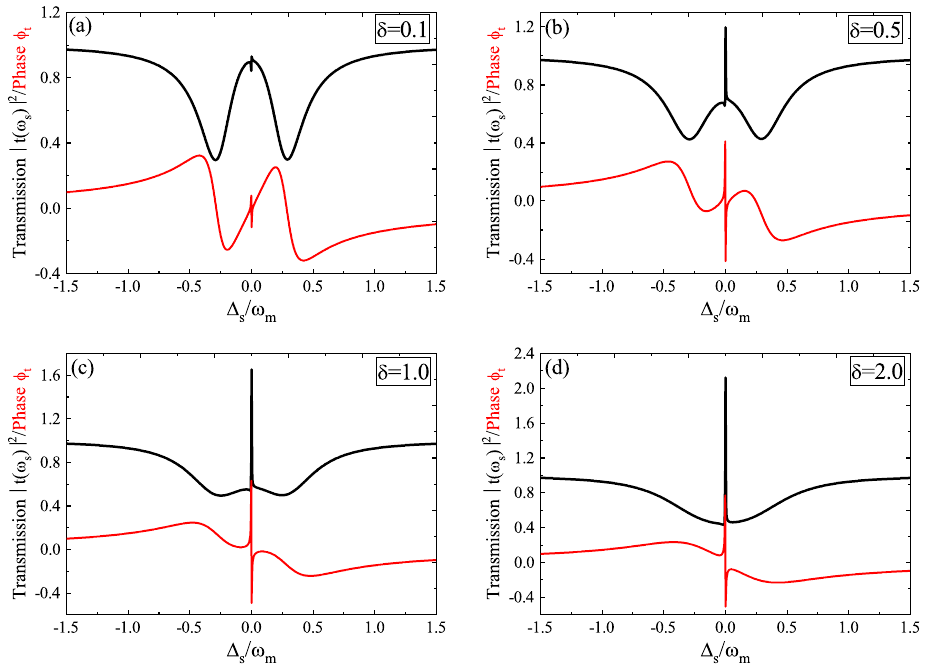
Figure 6. The transmission T and phase φ t as a function of ∆ s for four ratio parameters δ : ( a ) δ = 0.1; ( b ) δ = 0.5; ( c ) δ = 1.0; ( d ) δ = 2.0.